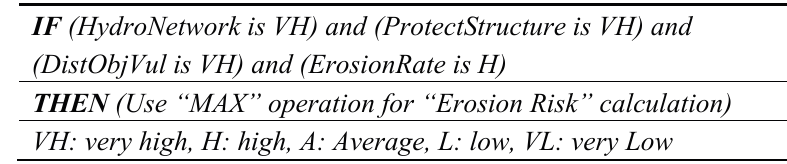
Table 2. An example of fuzzy IF-THEN